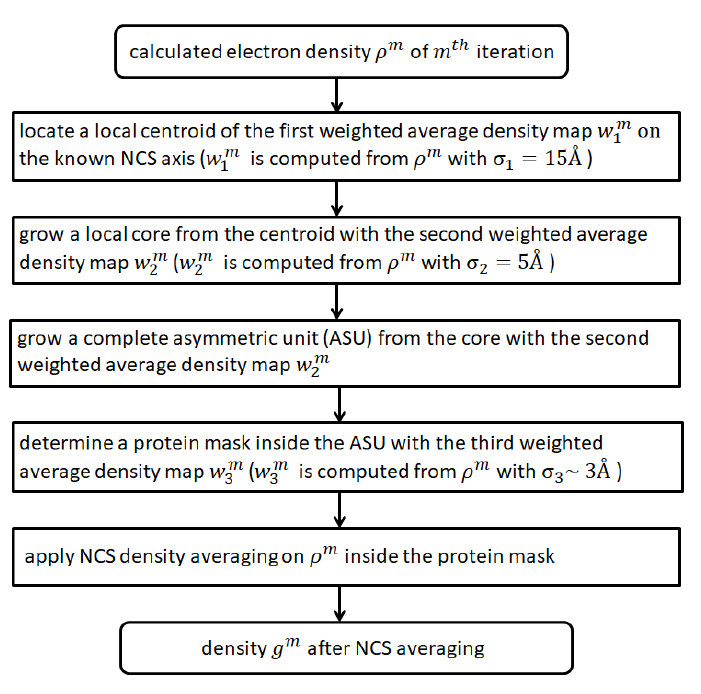
Figure 2. An example of the construction of the core, asymmetric unit (ASU), and NCS mask. ( a ) The updated centroid P. ( b ) High-density region of the core. ( c ) A complete core. ( d ) The core and its crystallographic-symmetry copies indicated by different colors. ( e ) The boundary of the core. ( f ) Grid points close to the core boundary. ( g ) All grid points close to the core boundary together with the core make up a new complete asymmetric unit. ( h ) The new asymmetric unit and its crystallographic-symmetry copies. ( i ) The boundary of the new asymmetric unit. Warm color represents high-density regions and cool color indicates low-density regions. ( j ) An NCS mask is defined inside the new asymmetric unit by an appropriate cutoff value based on a third weighted average density map w 3 with σ 3 around 3 . ( k ) The new NCS mask. ( l ) The NCS mask and its crystallographic-symmetry copies.